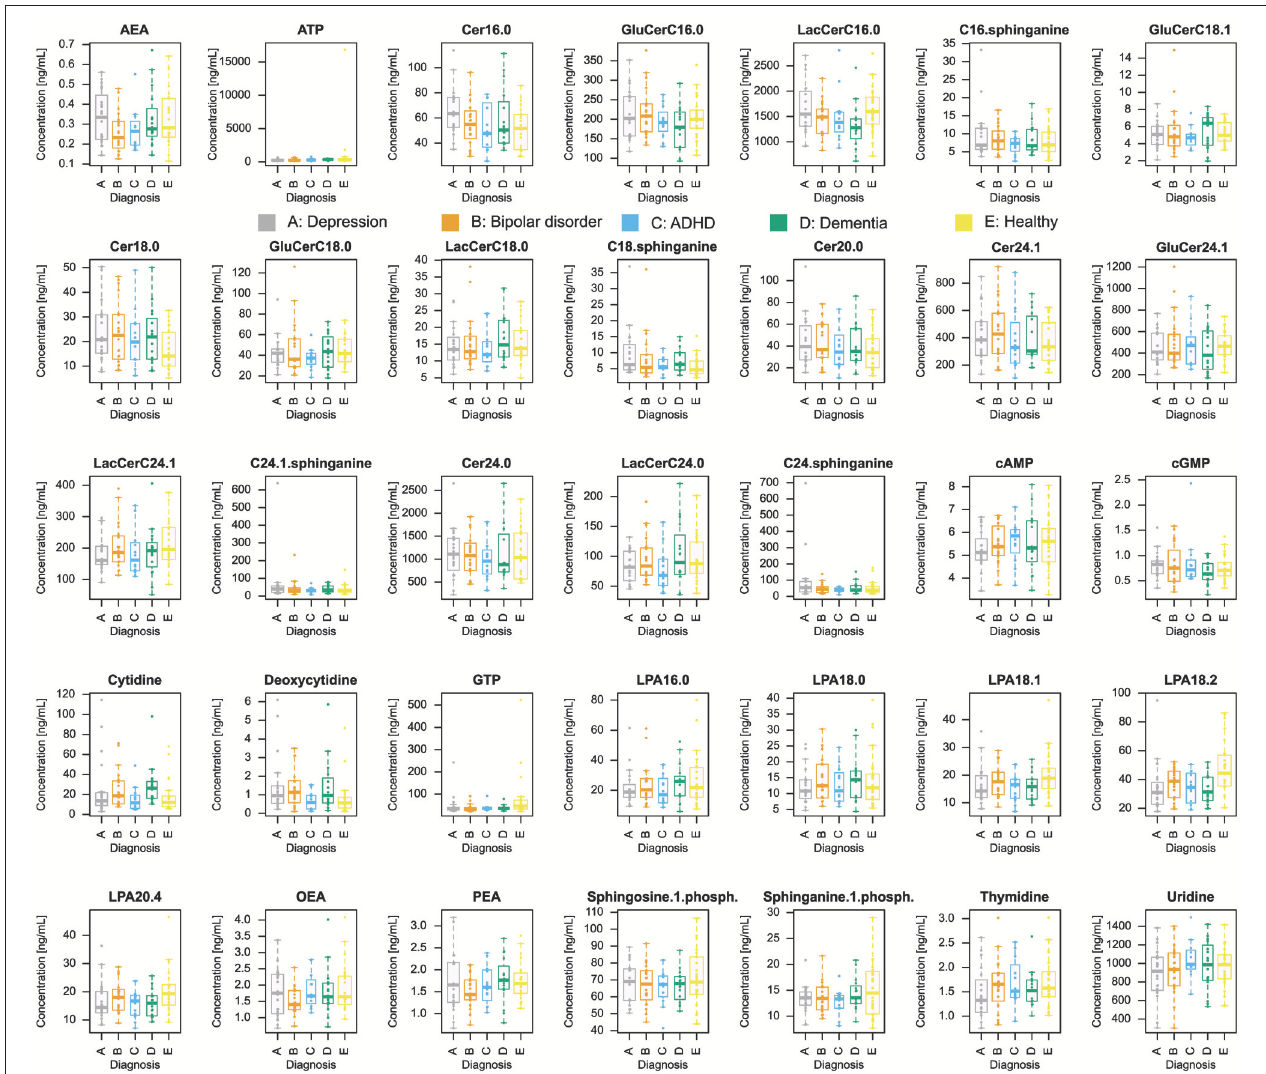
FIGURE 1 | Plasma concentrations of d = 35 lipid mediators (raw data). The data are shown in alphabetical order of lipid mediator names and for each mediator, separately for group membership to the five diagnoses (coded as A to E for depression, bipolar disorder, ADHD, dementia, or controls, respectively). The widths of the boxes are proportional to the respective numbers of subjects per group. The quartiles and medians (solid horizontal line within the box) are used to construct a “box and whisker” plot. Single data are shown as dots. The whiskers add 1.5 times the interquartile range (IQR) to the 75th percentile or subtract 1.5 times the IQR from the 25th percentile and are expected to include 99.3% of the data if normally distributed. The figure has been created using the R software package [version 3.4.4 for Linux; http://CRAN.R-project.org/; (13)].